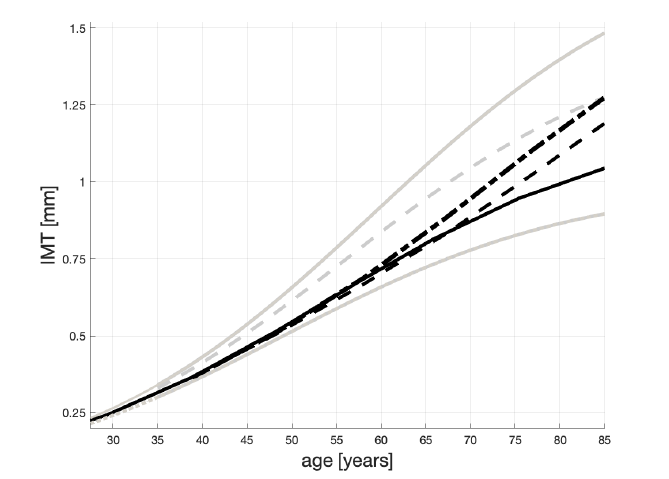
Figure 5. How IMT can evolve given hsCRP age profiles in Figure 3. The gray lines are copied from Figure 1, where the dashed line represents atherosclerosis non-sufferers; the solid line—not healthy but not necessarily “heavy” sufferers; the solid line—“heavy” sufferers. Each evolution is a result of an hsCRP scenario (Figure 3) and, then, of the corresponding progression of the maximum IMT level (Figure